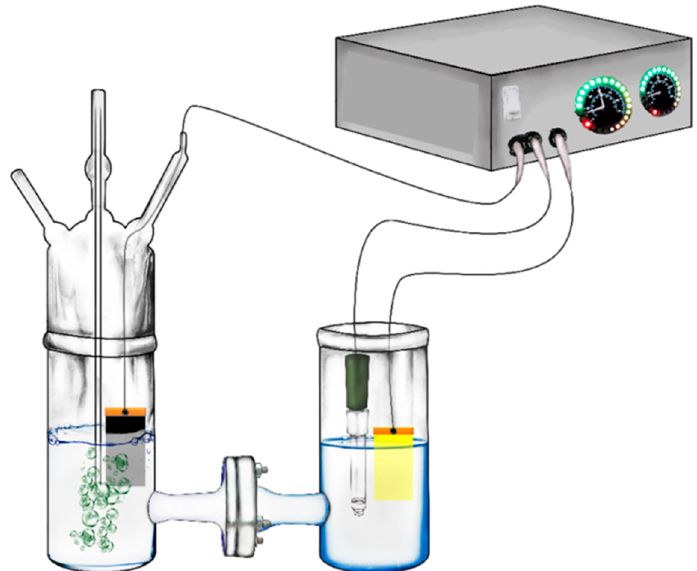
Figure 2. Graphical design of the employed reactor showing connections with a potentiostat. The reactor consists of two compartments separated by an ion transfer membrane. The compartment on the left accommodates the counter electrode and the one on the right the working and the reference electrode.